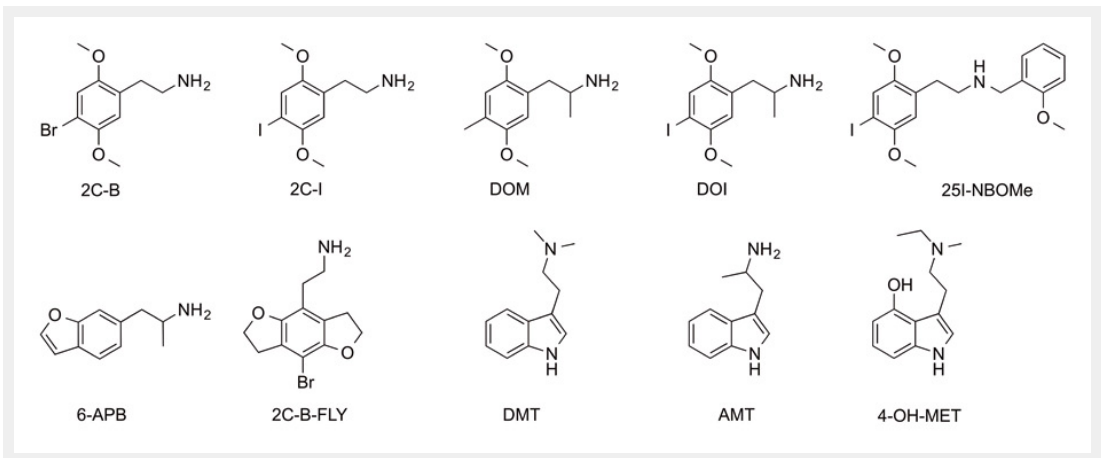
Structures of representative novel psychoactive substances (hallucinogenic phenethylamines, furans and difurans, and hallucinogenic tryptamines). Chemically, the shown substances include phenethylamines of the 2–C series (2C-B, 2C-I, and 25I-NBOMe) and of the 2–D series (DOM and DOI), a bezofuran (6–APB), a benzodifuran (2C-B-fly), and tryptamines (DMT, AMT, and 4–OH-MET). Pharmacologically, all presented substances are hallucinogens and potent serotonin 5–HT 2A receptor agonists except for 6–APB which is an empathogen and indirect serotonin agonist similar to